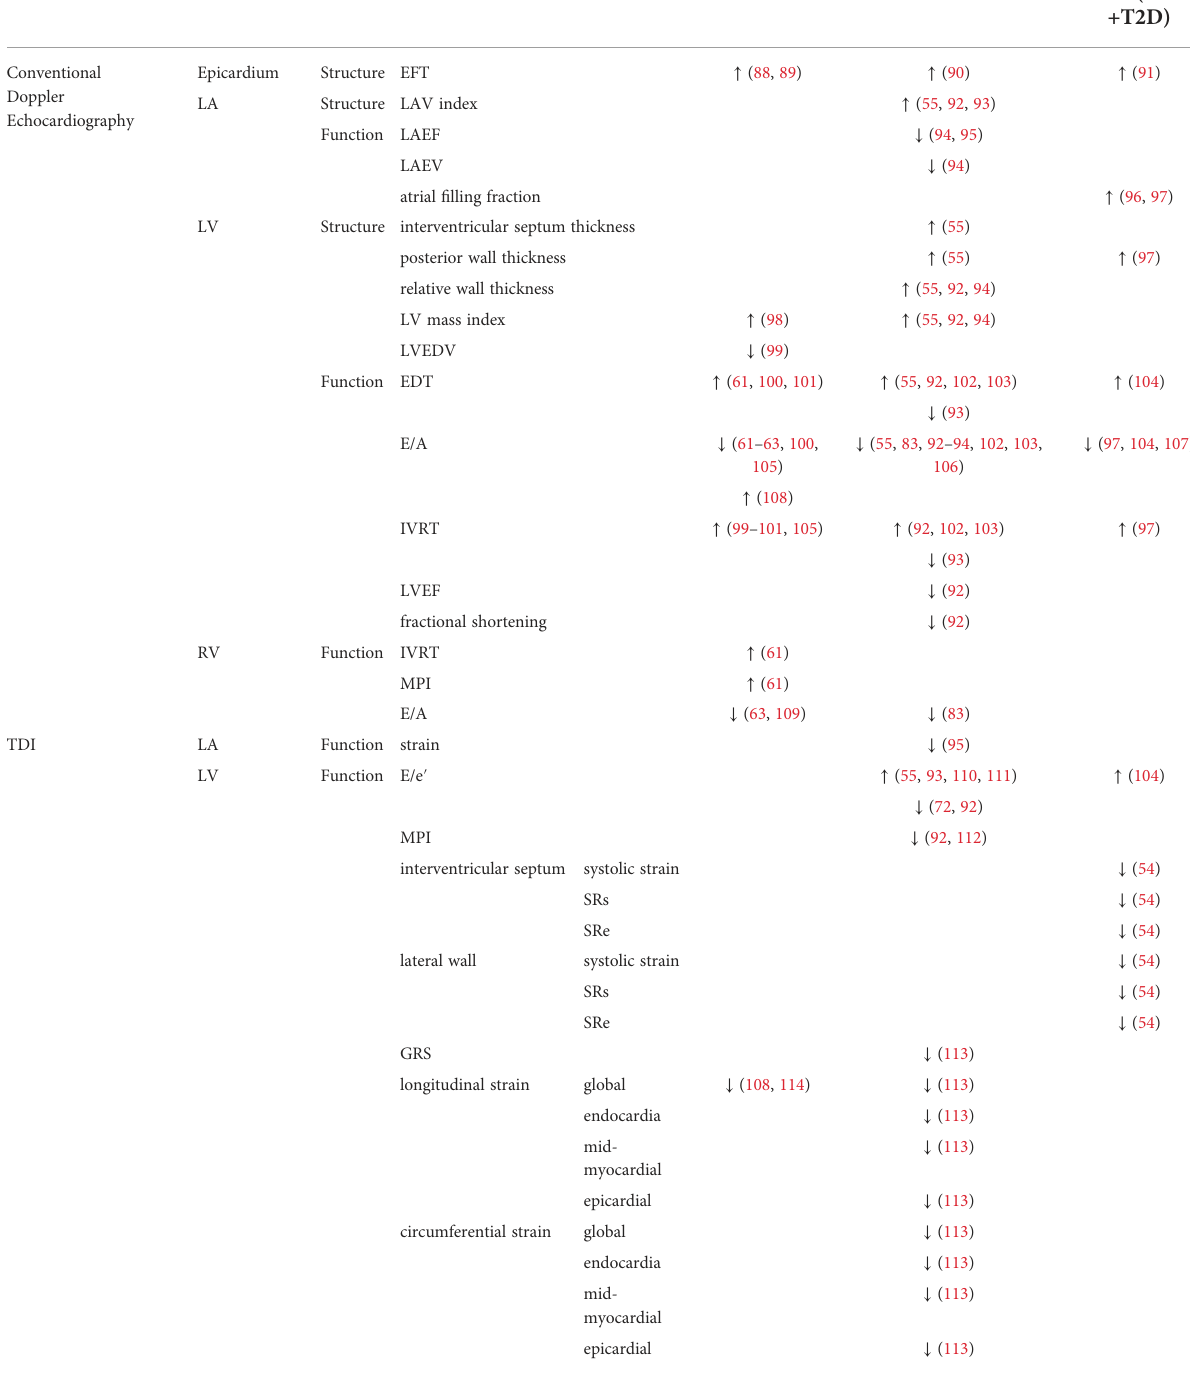
TABLE 2 Main clinical fi ndings of ultrasound for cardiac dysfunction in T1D and T2D